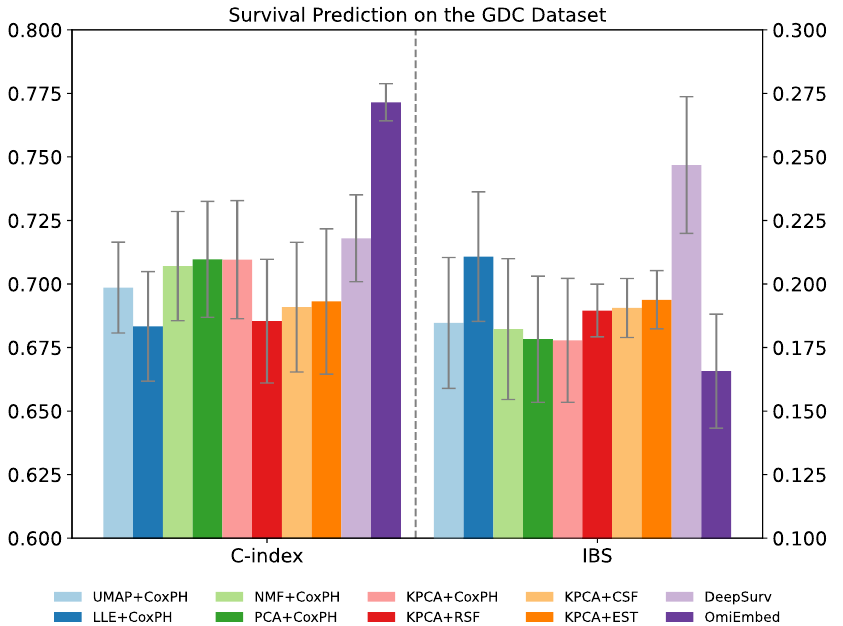
Figure 6. Performance comparison of OmiEmbed and other nine methods for the survival prediction task on the GDC dataset. For C-index, higher values mean better prediction performance. For IBS score, lower values mean better prediction performance.